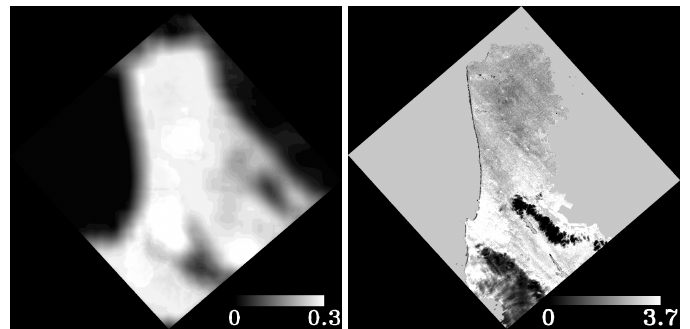
Figure 5. DESIS scene of San Francisco bay (10 October 2018): ( Left ) aerosol optical thickness map (Mask Layer 9); and ( Right ) water vapor map (Mask Layer 10). The maximum value in the plots corresponds to an AOT value of 0.26 and WV = 3.7